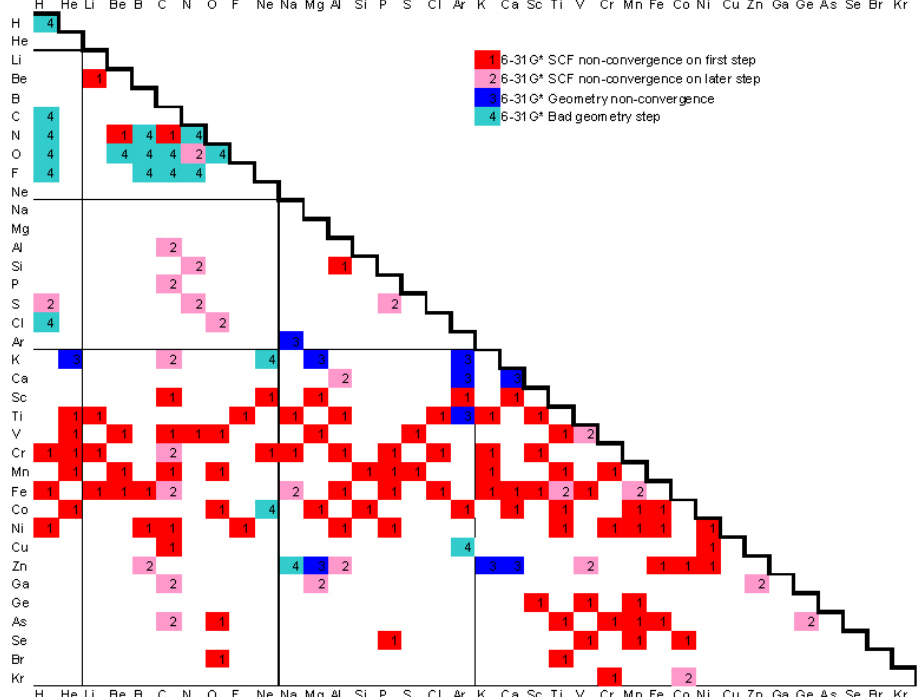
Figure 1. Results of running HF/6-31G* optimization calculations on the test set. The position in the figure identifies the particular diatomic. White indicates normal completion. Red values indicate that the SCF failed to converge on the first step. Pink values indicate that the SCF failed to converge at some later geometry step. Blue values indicate that the geometry did not converge. Green values indicate that the geometry took a bad step which resulted in an optimization error.